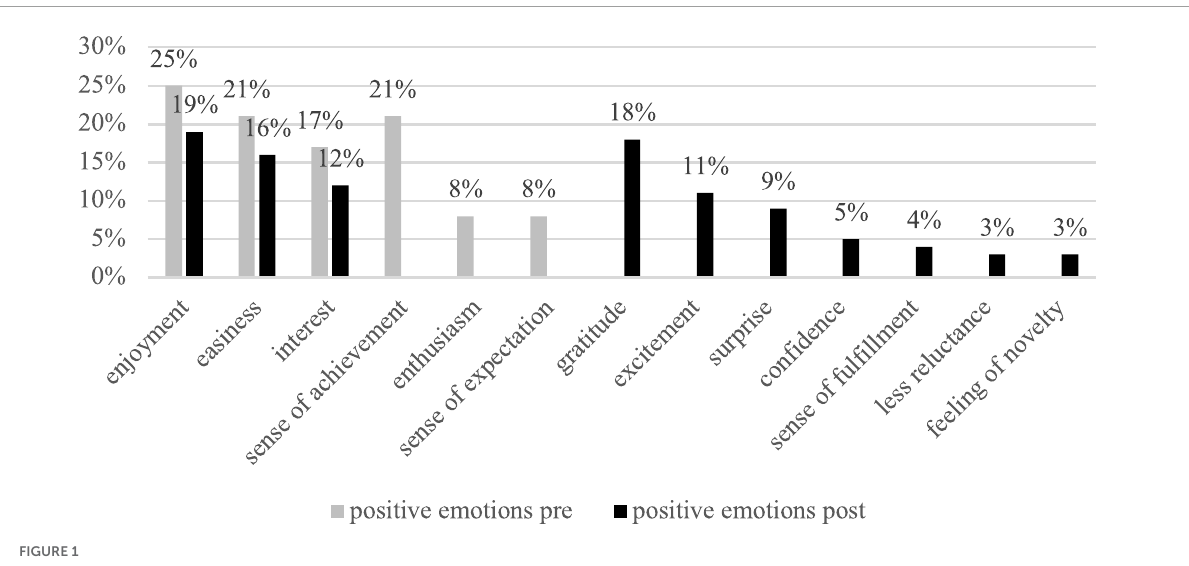
that negative emotions led to negative cognition to further negative behaviors. As the case of Vicky, her lower confidence in listening and speaking abilities (cognition) led to her denial of the usefulness of classroom presentation (emotion).